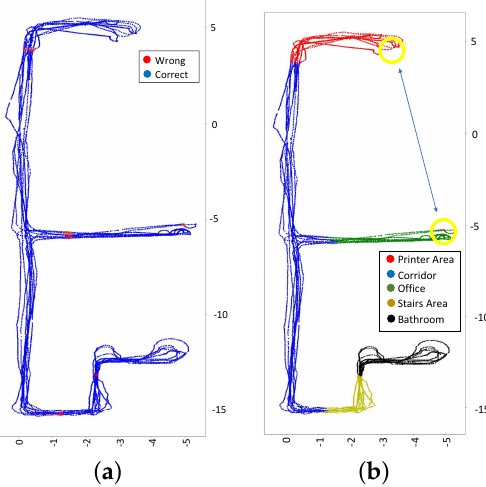
Figura 35. Representaciónde predicciones por habitación. Como se puede ver, la suposición era correcta. Por algún motivo, aunquenopresentan conectividad,en los extremos las habitaciones 2PO1 y PA, son confundidas.